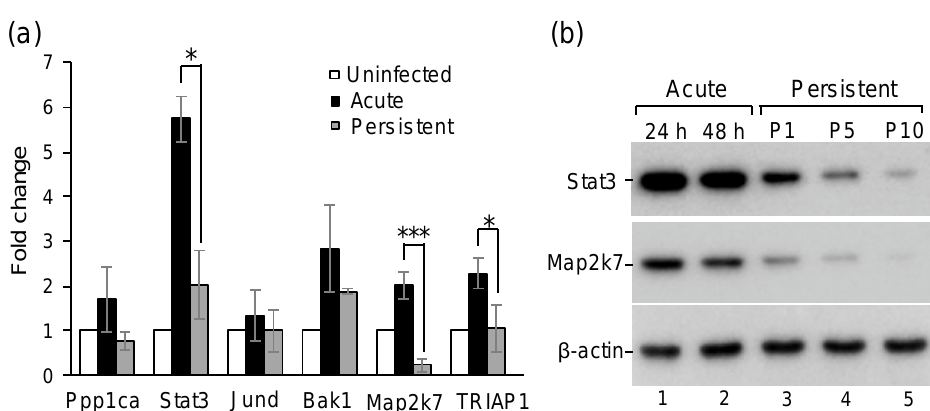
Figure 5. Downregulation of miR-12b-5p-targeted genes in the persistently JEV-infected cells. ( a ) Six predicted miR-125b-5p target genes were downregulated in persistently infected cells compared with the acutely infected cells. Total RNAs were extracted from uninfected, acutely infected, and persistently infected cells at 24 hpi (P10), and the amounts of the six genes were analyzed by RT-qPCR. The relative fold change was normalized to mock-infection. Bars represent the mean ± SD ( n = 3). *: p -value < 0.05; ***: p -value < 0.001 comparison between acute and persistent infections was analyzed by a Student’s t -test. ( b ) Decreased expressions of both Stat3 and Map2k7 in persistently JEV-infected cells in comparison with acutely infected cells. Cell lysates from acute or persistent infection, as indicated on the top, were analyzed by 10% SDS-PAGE and Western blotting with antibodies, as indicated on the left.